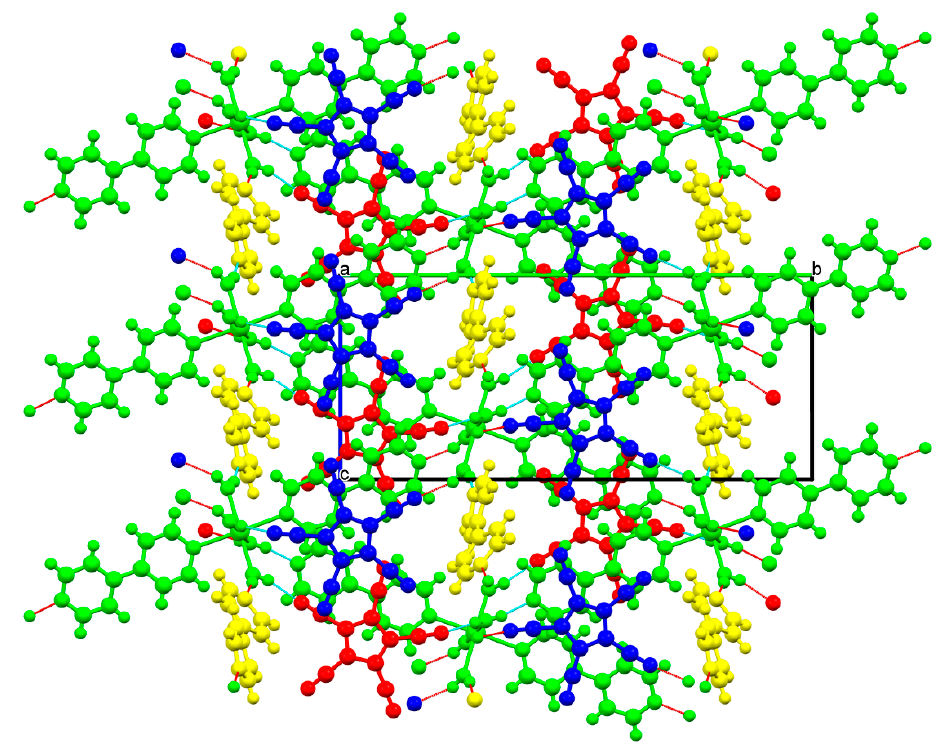
Figure 8. Complete packing diagram of compound 2 , watched along a . Color coding: green and yellow: see Figure 7; red and blue: the two independent anions.